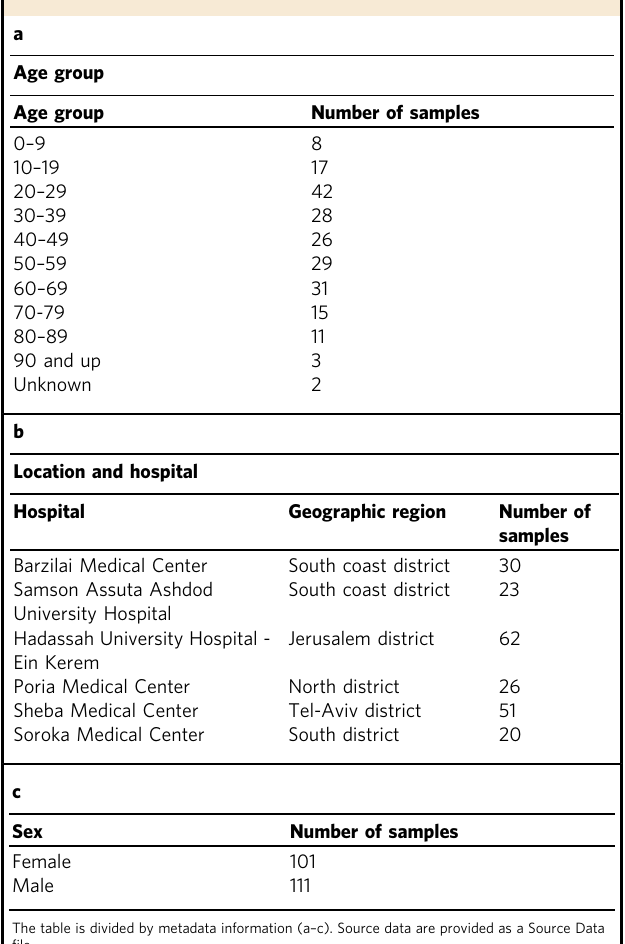
Table 1 Summary of samples successfully